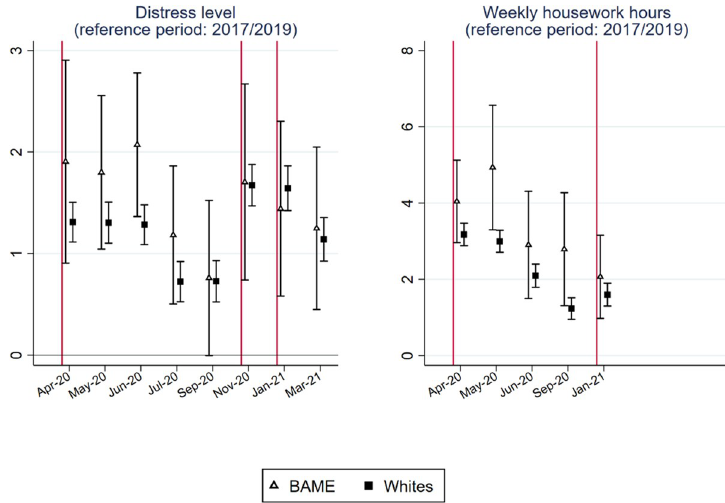
Fig 7. Point estimates and 95% confidence interval of the race-period interaction models to predict subjective wellbeing and housework